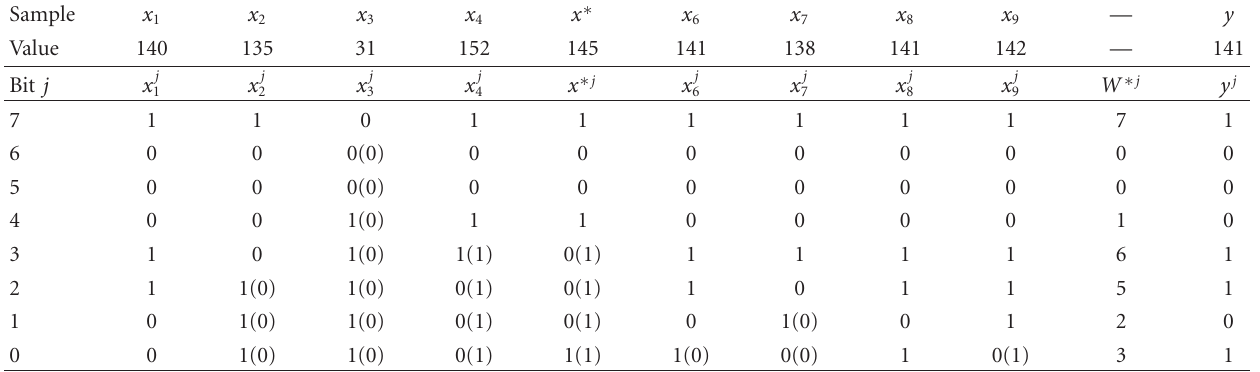
Table 3: LUM-PBF smoothing ( N = 9 and k = 4) realized via the bit-serial approach.